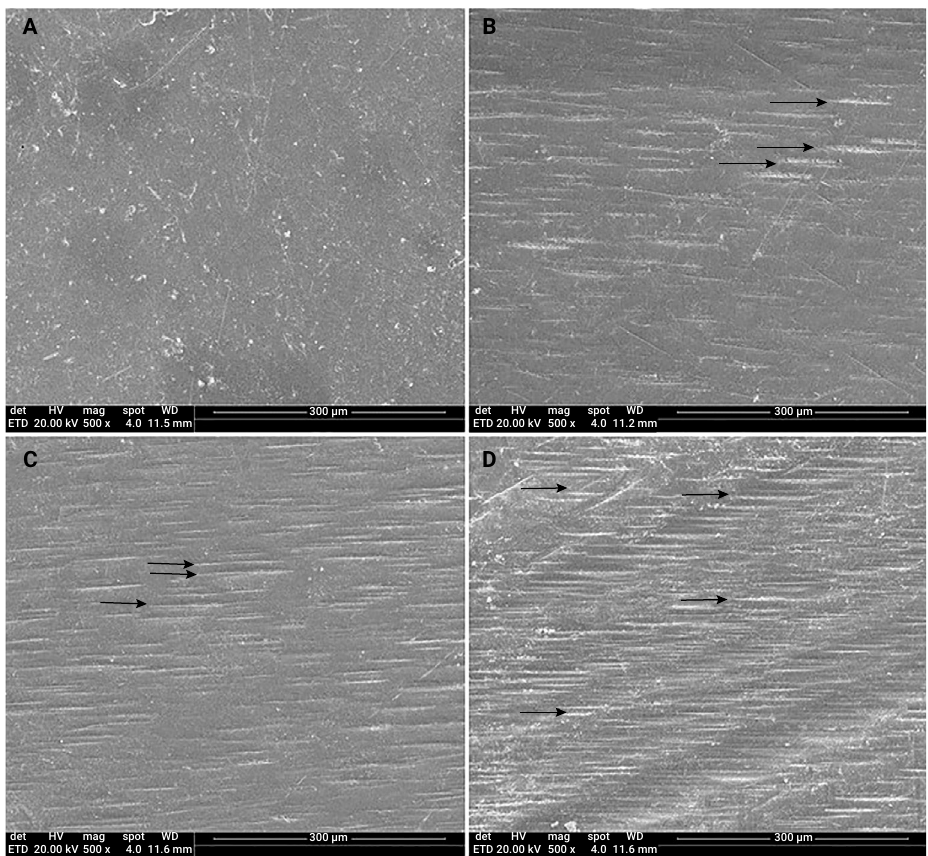
Figure 1. SEM images of Y-TZP surface (500x). (A): glazed surface; (B): polished with CeraGloss System; (C): polished with Komet System; (D): polished with Eve Diacera System. Black arrows indicate grooves caused by the diamond